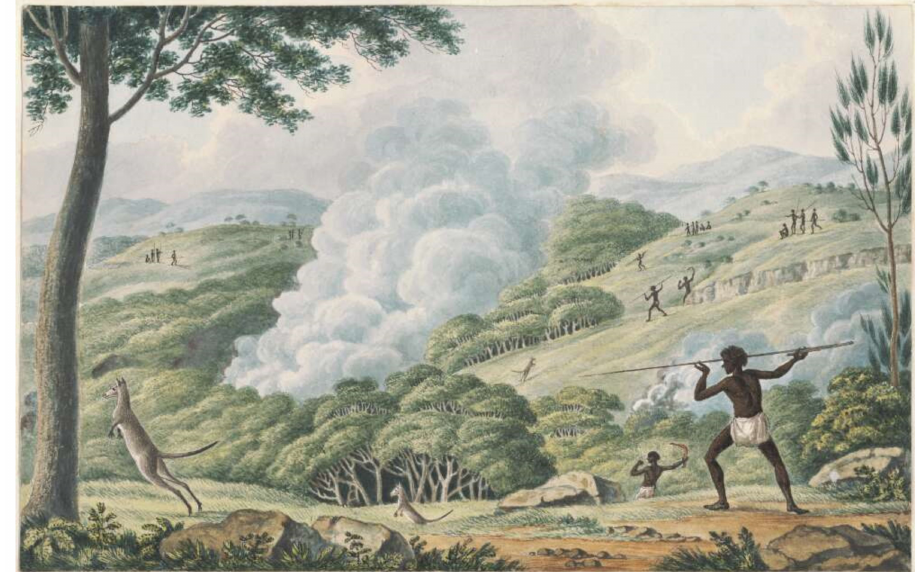
Figure 2. Aborigines using fire to hunt kangaroos by Joseph Lycett 1817 (source: http://nla.gov.au/nla.obj-138501179; accessed on 21 April